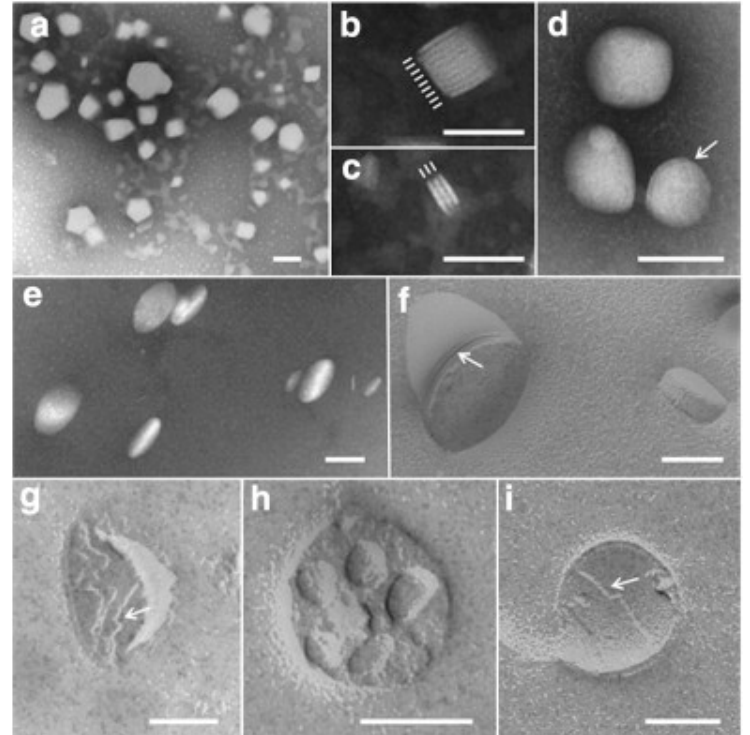
Figure 2. Transmission electron micrographs of nanoparticles [33]. The morphology of nanoparticles produced with a range of polymers is shown here. The white scale bars indicate 100 nm. a – c : PGA- stearate 20%, stained with uranyl acetate. d : PGA-behenate 45%, stained with uranyl acetate. e + f :